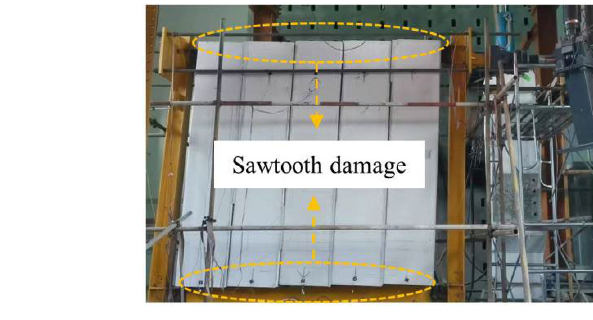
Figure 18. Comparison of results by finite element analysis and test. ( a ) Comparison of failure modes of ALC panels. ( b ) Comparison of the slipping of connecting bolts.